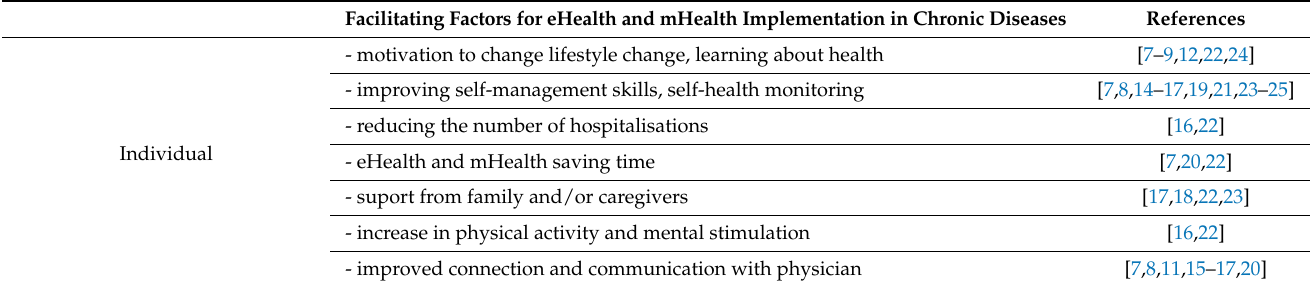
Table 2. Overview of the